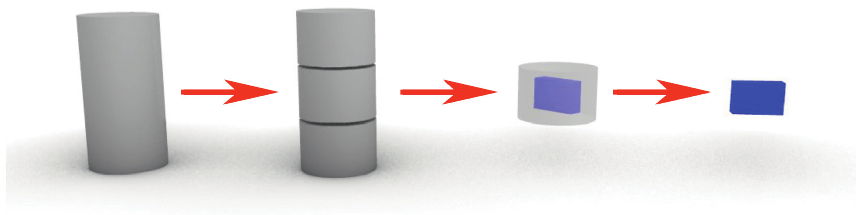
Figure 3: Schematic diagram of test slice cutting.